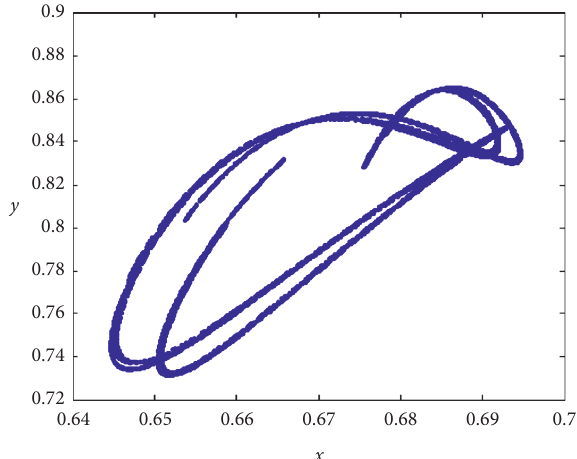
Figure 12: x – n sequence diagram which denotes that the system is chaotic when β � 0.7.